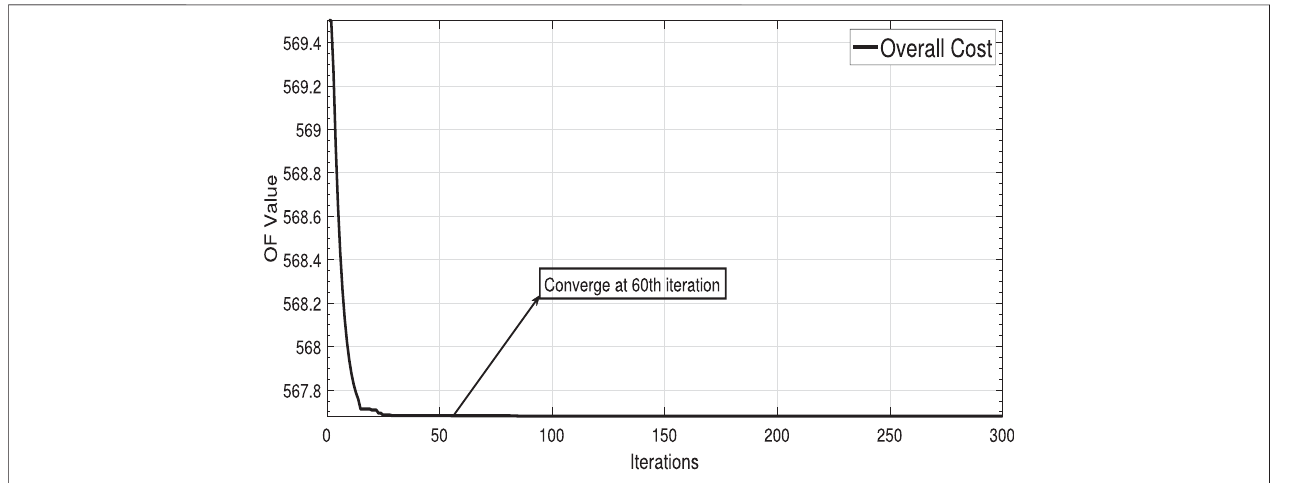
FIGURE 11 | Contribution of GSs in